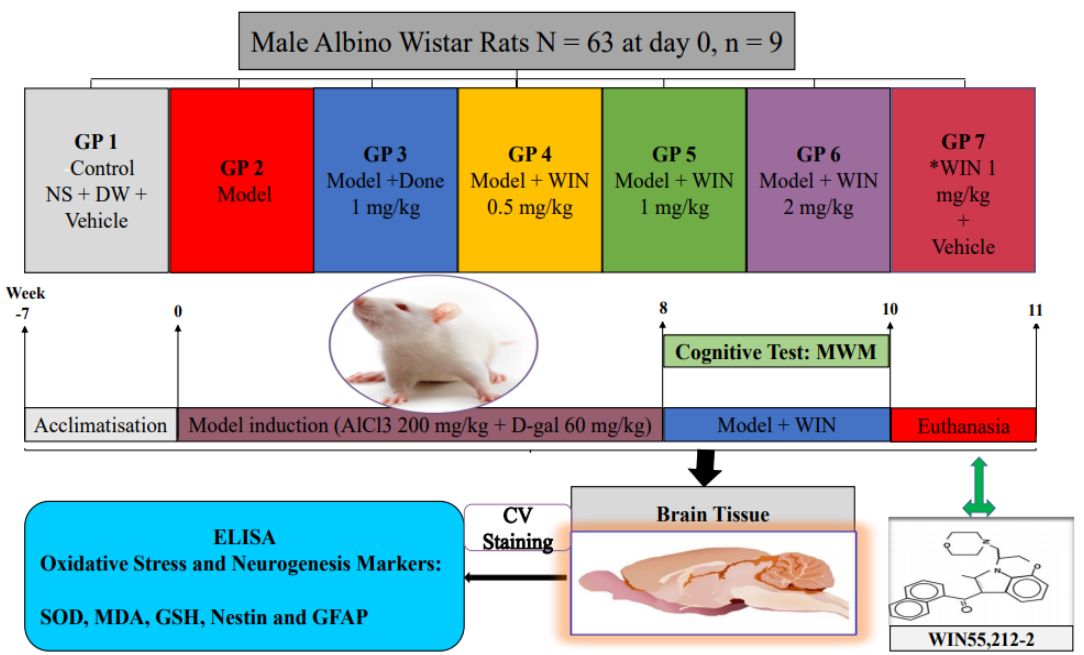
Figure 1. Experimental design to test rat’s cognitive function, check the level of damage on the hippocampus and quantify oxidative stress and neurogenesis markers following the induction of cognitive impairments by AlCl 3 and D - gal co-administered with WIN. SOD—superoxide dismutase, MDA—malonaldehyde, GSH—glutathione, GFAP—glial fibrillary acidic protein, CV Staining—Cresyl Violet Acetate, GP—group, NS—normal saline, DW—distilled water, Model—AlCl 3 + D -gal, AlCl 3 —Aluminium chloride, D -gal— D -galactose, Done—Donepezil, MWM—Morris Water Maze, WIN—synthetic cannabinoid agonist,